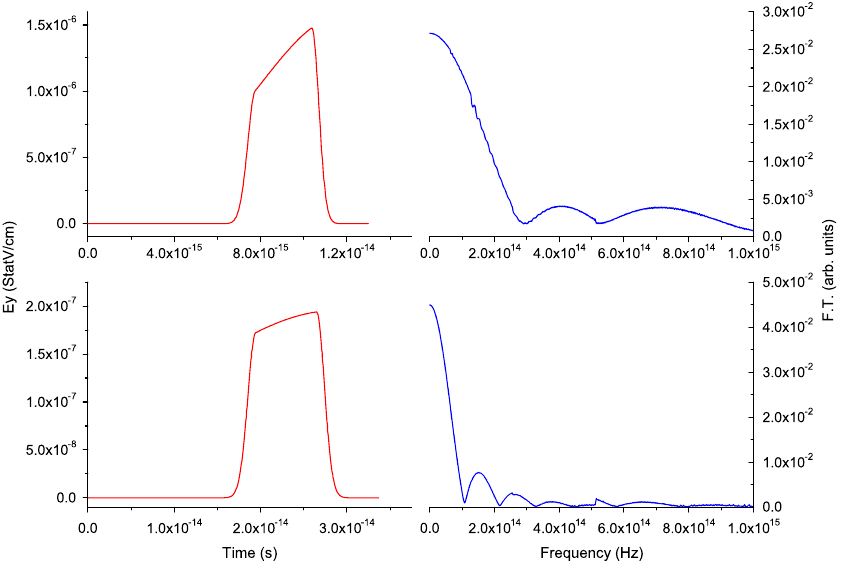
FIG. 8. (Color) Time signals (left) and their Fourier transforms (right) for two different values of x .